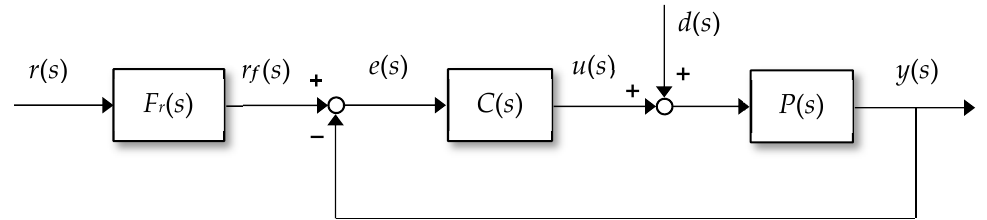
Figure 2. Structure of 2-DOF (2-degree of freedom) PID control systems with set-point filter. Where F r ( s ) is the transfer function of the set-point filter, r ( s ) and r f ( s ) are the input and output of the set-point filter, respectively.